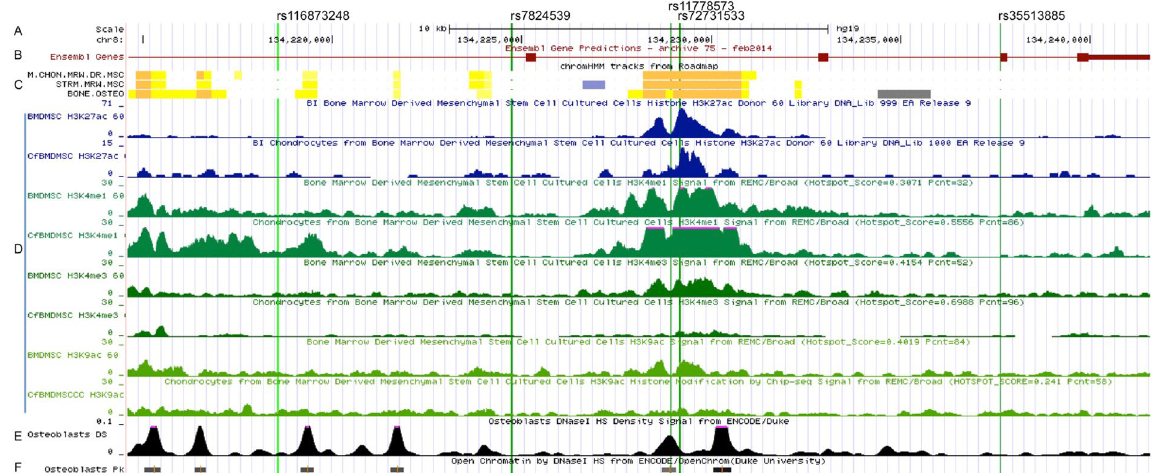
Figure 4. UCSC bioinformatics view of the WISP1 region (chr8:134214753–134241422, GRCh37/hg19). The light green, long vertical line indicates the position of SNPs. ( A ) The Base Position feature; ( B ) The WISP1 gene prediction using Ensembl gene prediction; ( C ) the chromatin state segmentation for the cell types using the imputed ChromHMM (Hidden Markov Model), orange: active enhancer, yellow: weak enhancer or enhancer acetylation, PaleTurquoise: Het (Heterochromatin), Silver: ReprPC (Repressed PolyComb); ( D ) four histone markers modification map in two cell lines generated by Broad Institute using ChIP-Seq. ( E ) shows the density signal of DNaseI HS and ( F ) shows the peaks of DNaseI HS in the osteoblast from ENCODE/OpenChrom(Duke University). HMM (Hidden Markov Model), STRM.MRW.MSC and BMDMSC (Bone Marrow Derived Mesenchymal Stem Cell Cultured Cells; M.CHON.MRW.DR.MSC and cfBMDMSC (Chondrocytes from Bone Marrow Derived Mesenchymal Stem Cell Cultured Cells); BONE.OSTEO (primary osteoblast); DS (density signal); PK (peaks).